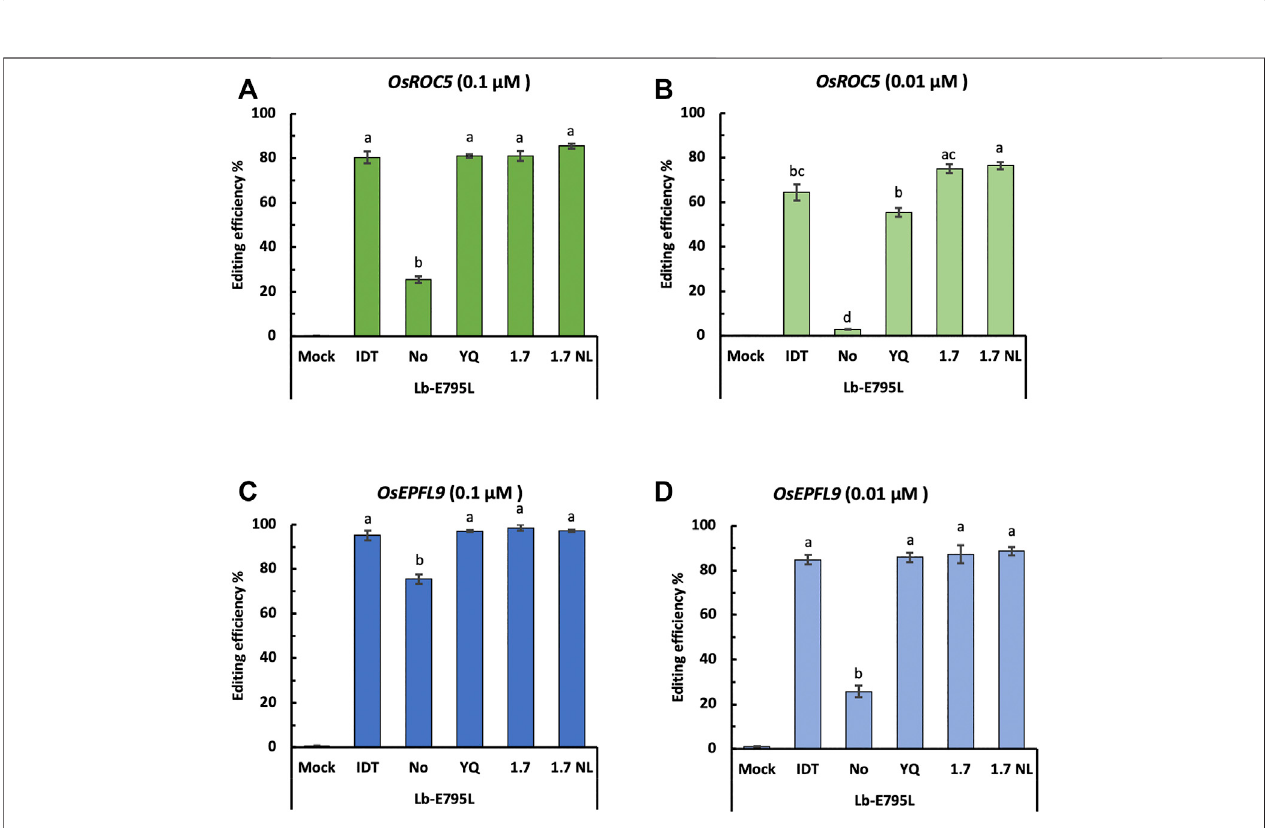
FIGURE 6 | Cas12a editing ef fi ciencies using different nuclear localization signals (NLSs) in rice cells with RNP delivery. Editing ef fi ciencies of Cas12a-E795L without or with different NLSs were tested in rice cells with RNP delivery at the two target sites at 32 ° C. Editing ef fi ciencies are calculated using the RFLP assay with two RNP concentrations, 0.01 and 0.001 µM, at the OsROC5 (A,B) and OsEPFL9 (C,D) sites. Data are presented as mean values ±SEM of three biologically independent replicates.Editingef fi cienciesusingCas12anucleaseswithoutorwithdifferenttypesofNLSsarecomparedusingTukey ’ sHonestSigni fi cantDifference(HSD)test. Treatments with the same letter are not signi fi cantly different when α =